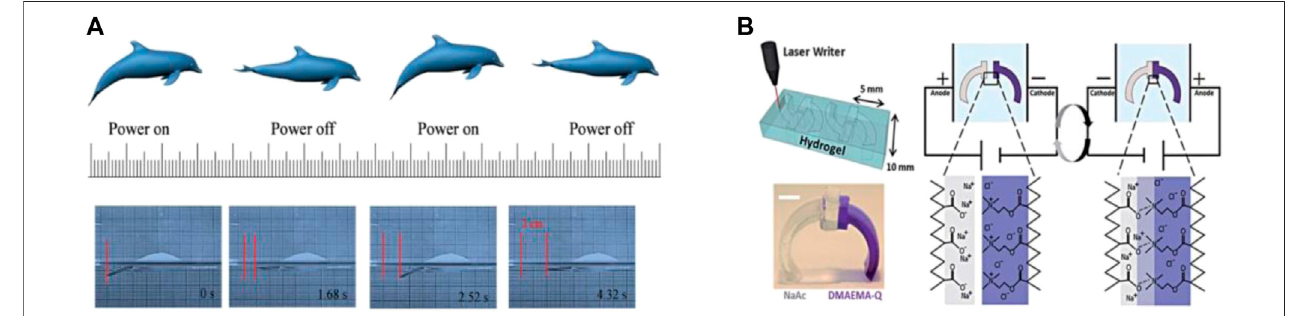
FIGURE 3 | (A) fi sh-like robot swimming, when the power is on or off, the “ tail ” bends down or up, then the fi sh-like robot will swim. Reproduced from Xiao et al. (2016)withpermissionofWILEY-VCH. (B) Basedonthegelelectricstimulationofthesmartactuatorandwalkingundertheelectric fi elddrive.ReproducedfromMorales et al. (2014) with permission of Royal Society of